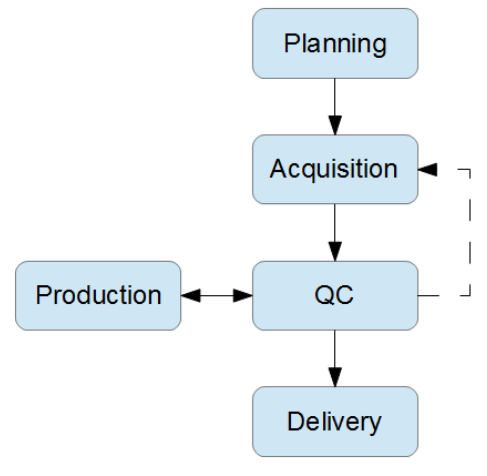
Figure 1: High level work flow